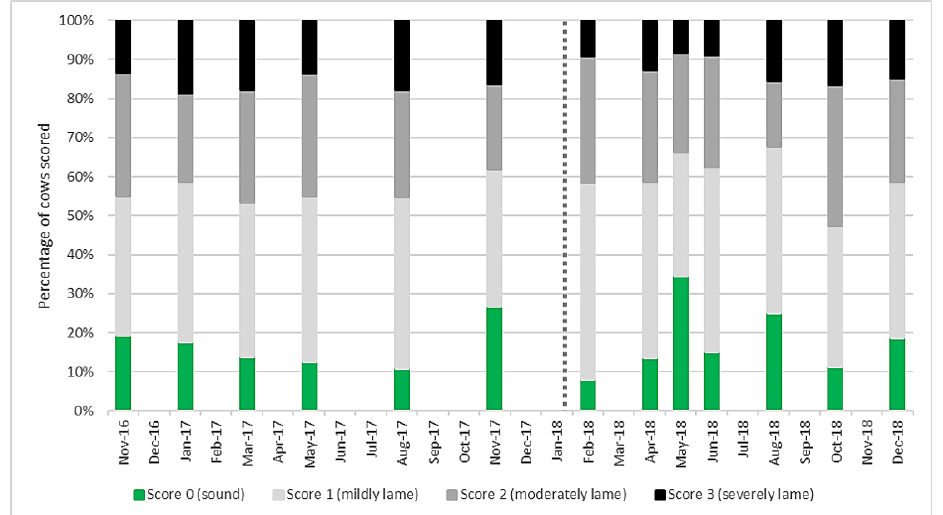
Figure 1. Mobility score results for the main milking herd ( n = 101 ± 6) at each recording session from November 2016 to December 2018. Score 0 are sound cows, with scores of 1–3 representing worsening degrees of lameness. The vertical dotted line represents automatic milking system (AMS) installation.